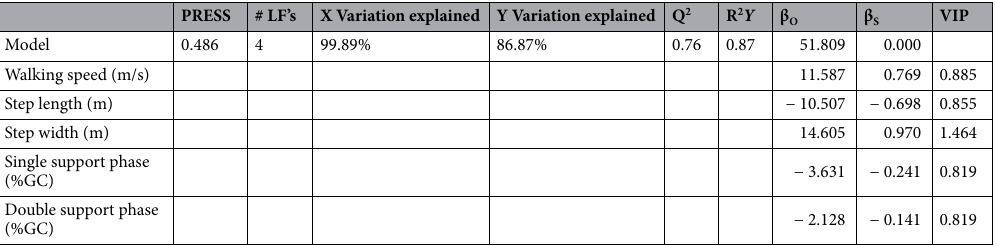
Table 5. Results of the partial least squares model for the ML MoS in BVP-patients. ML MoS: Medio-lateral margin of stability; PRESS: Predictive Residual Sum of Squares; # LF’s: number of Latent Factors; Q 2 : goodness of prediction; R 2 Y : goodness of fit; β O : regression coefficient for original data; β S : regression coefficient for centred and scaled data; VIP: Variable Importance in Projection; m/s: metres per second; %GC: percentage of gait cycle.